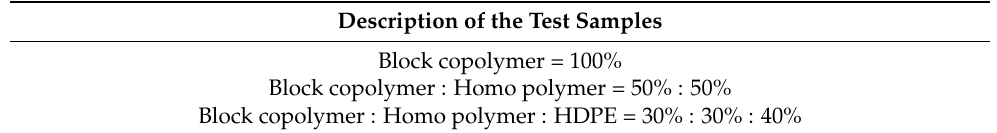
Table 1. The test samples for V-t characteristic test.